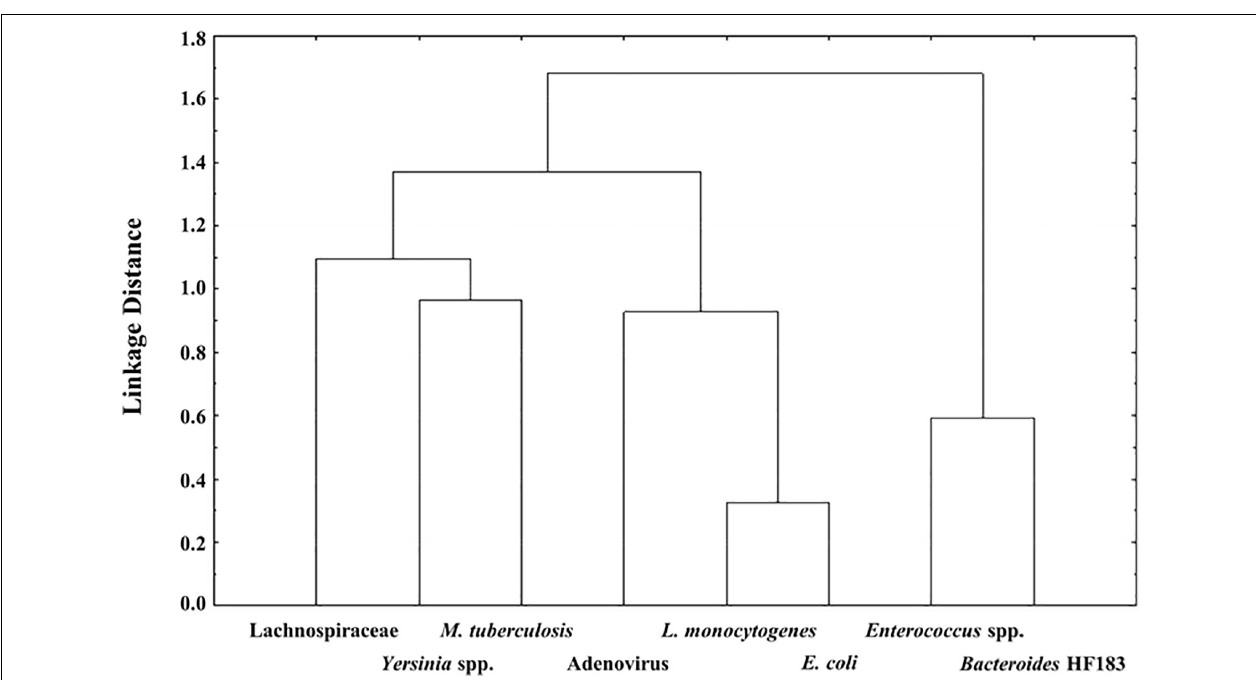
FIGURE 2 | Dendrogram of the Cluster Analysis with Ward’s Methods of target pathogens versus the MST markers and indicator organisms detected in the RHRW